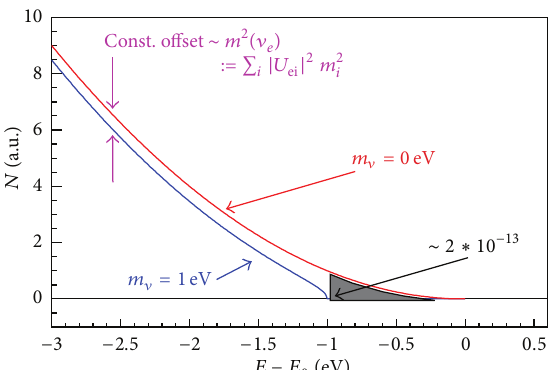
Figure 3: Expanded 𝛽 -spectrum of an allowed or superallowed 𝛽 - decay around its endpoint 𝐸 0 for 𝑚(𝜈 𝑒 ) = 0 (red line) and for an arbitrarily chosen neutrino mass of 1eV (blue line). In the case of tritium (see Section 2.2), the gray-shaded area corresponds to a fraction of 2 ⋅ 10 −13 of all tritium 𝛽